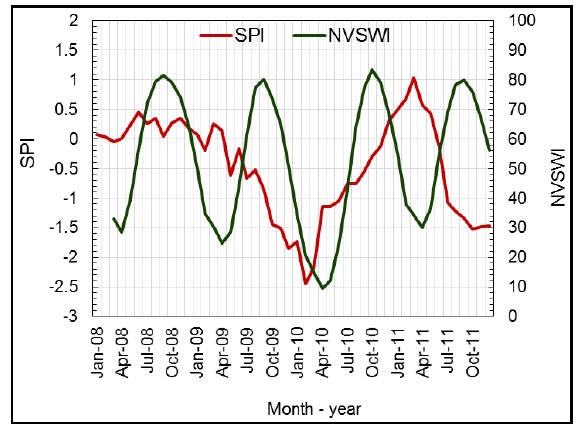
Figure S3. SPI and NVSWI time series plots.